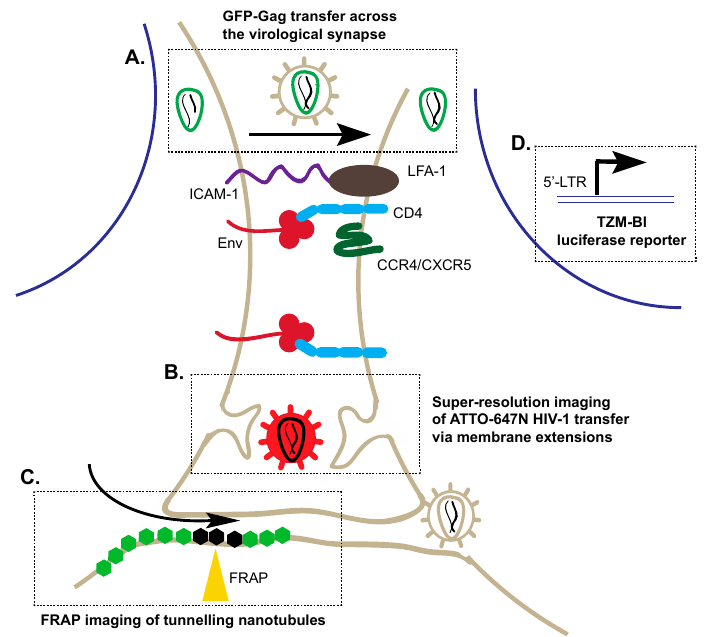
Figure 2. Techniques to visualize cell–cell transmission of HIV ‐ 1 through virological synapses and tunneling nanotubules. Upon engagement of Env with cluster of differentiation 4 (CD4) and C ‐ C chemokine receptor type 4/ C ‐ X ‐ C chemokine receptor type 5 (CCR4/CXCR5), there is a recruitment of host cellular factors including ICAM ‐ 1 and leukocyte function ‐ associated antigen 1 (LFA ‐ 1) to form the virological synapse. ( A ) 3D ‐ confocal microscopy enables the visualization of GFP ‐ Gag ( green ) particles across the virological synapse; ( B ) Super ‐ resolution imaging of ATTO ‐ 647N ( red ) demonstrated that labeled HIV ‐ 1 can be taken up by a neighbouring cell though protruding membrane extensions within the virological synapse; ( C ) Fluorescence recovery after photobleaching (FRAP) studies enable imaging of the dynamics of membrane proteins in live cells to investigate the structure of tunneling nanotubules. Hexagons represent membrane proteins; bleached: black , fluorescent: green ; ( D ) Co ‐ culture of infected primary cells with TZM ‐ Bl cells can be used to detect cell–cell transfer of HIV ‐ 1 by β‐ galactosidase activity, which is expressed under the regulation of the HIV ‐ 1 promoter; LTRs (long terminal repeats) are DNA sequences used by retroviruses to integrate into the host genome.